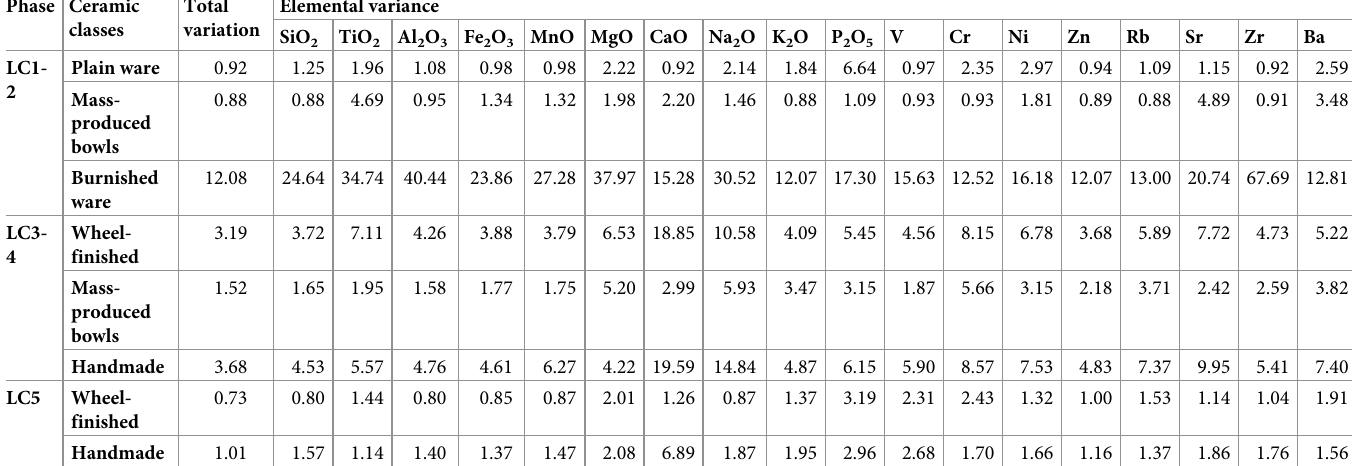
Table 7. Elemental variance and total variation according to ceramic classes, manufacturing rates and production rates. Phase Ceramic classes